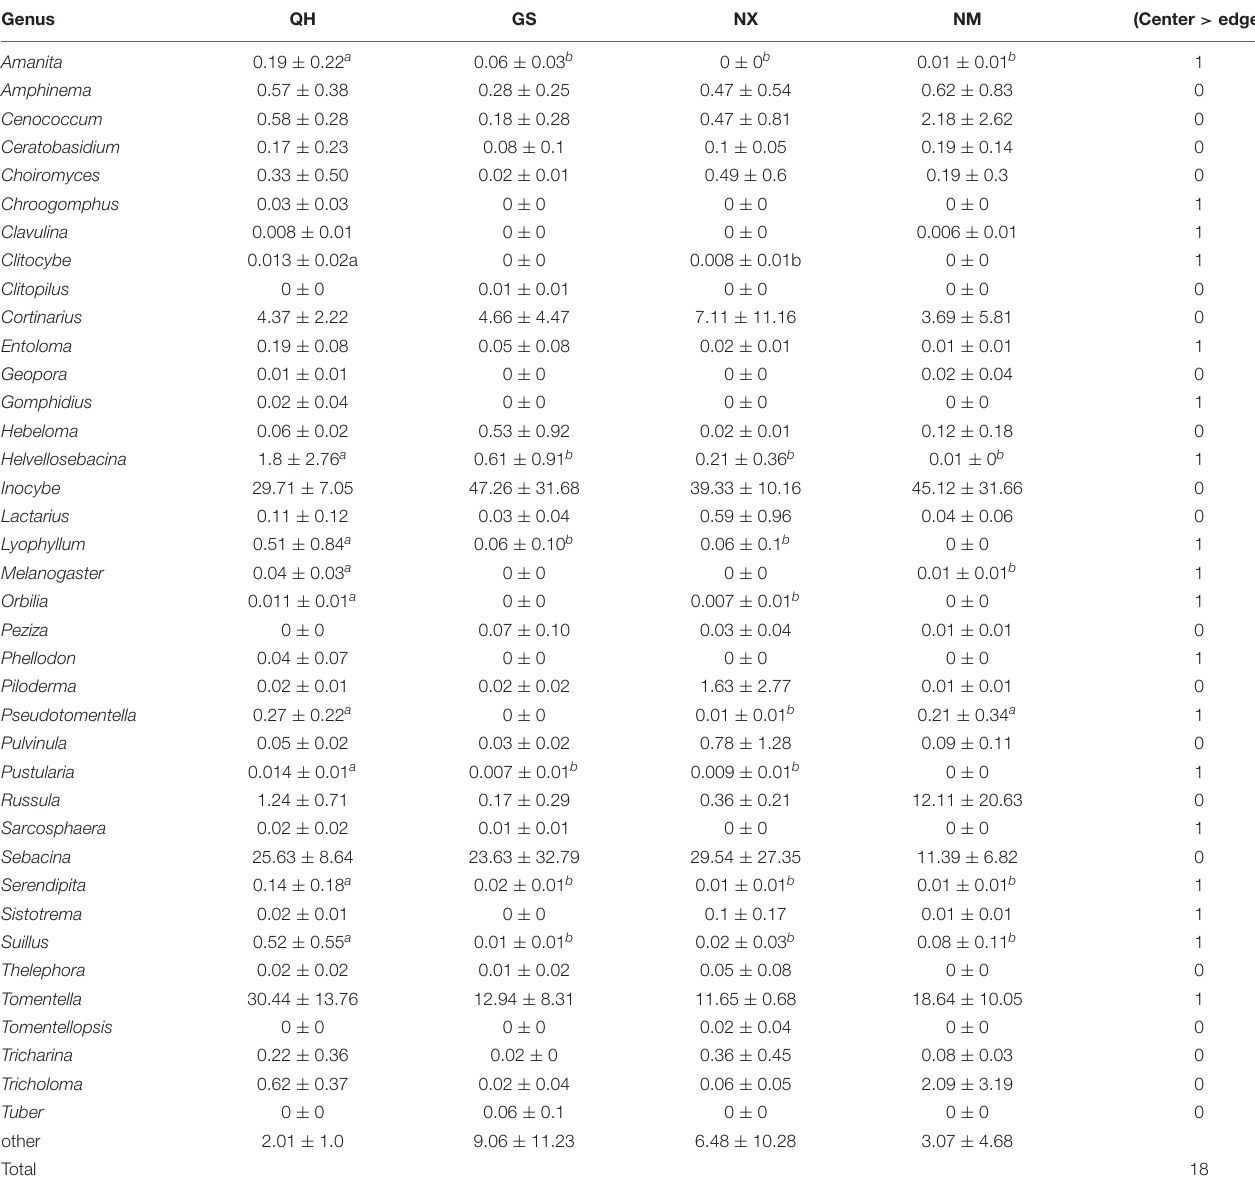
TABLE 3 | Comparing the differences of the ECM fungal relative abundance at genus level in four sites. Genus (Center >